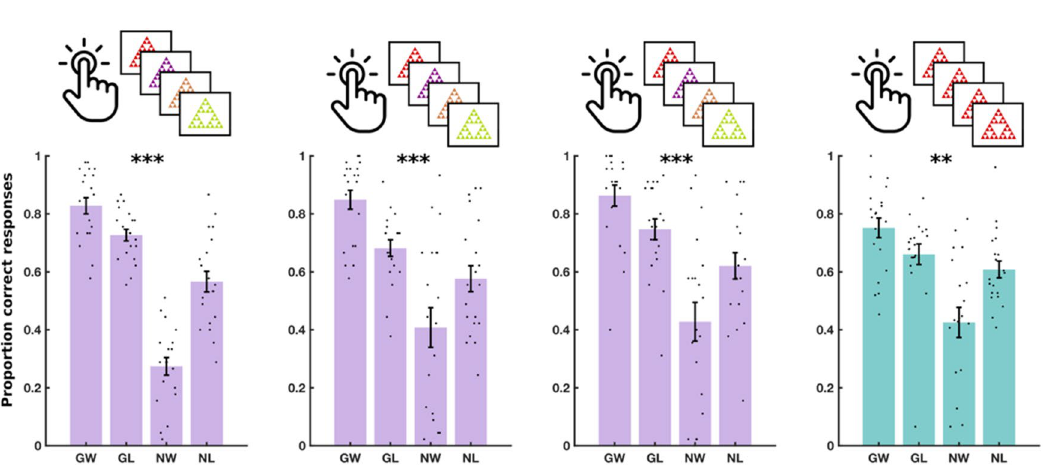
Figure 5. Experiment 3 results. Performance in three daily training sessions of M g− and a fourth testing session of MM on day 3. Each dot shows the average performance for an individual subject in one of the four conditions: Go to win (GW), go to avoid losing (GA), no-go to win (NW) and no-go to avoid losing (NL). Error bars show standard error of the mean across participants. Significance stars show p-value ranges for the interaction between valence (win/avoid losing) and choice (go/no-go) on performance. **p < 0.01. ***p <